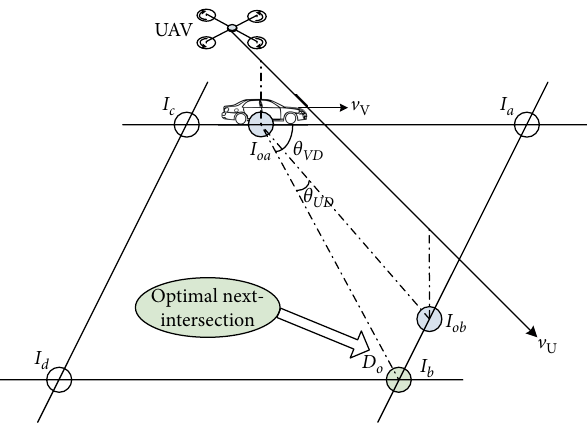
Figure 5: Illustration of calculation of forwarding